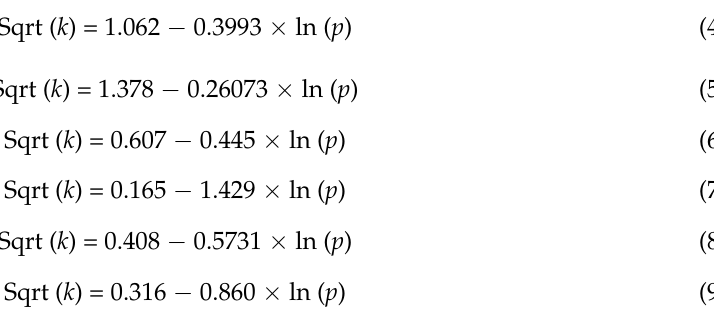
Figure 5. Survival of B. subtilis on the cardamom seed ( left ) and juniper berry ( right ) matrix treated with ozone doses stimulated with flow rate of 1.2, 0.8, 0.6, and 0.4 L/min after 5, 10, 20, 30, and 40 min. Solid line: prediction of the Weibull model (egns 6–7), dotted line: bacterial log counts. Figure 6. Survival of B. pumilus on the cardamom seed ( left ) and juniper berry ( right ) matrix treated with ozone doses stimulated with flow rate of 1.2, 0.8, 0.6, and 0.4 L/min after 5, 10, 20, 30, and 40 min. Solid line: prediction of the Weibull model (egns 8–9), dotted line: bacterial log counts. Concerning the Weibull model, it can be concluded that it was appropriate to describe a non-linear inactivation curves (Figures 4–10). Such findings are in agreement with Bialka 2008 [15] who developed the Weibull model of E. coli O157:H7 and Salmonella on blueberries, raspberries, and strawberries after ozone or pulsed UV-light treatment, indicating a non-linear character of survival